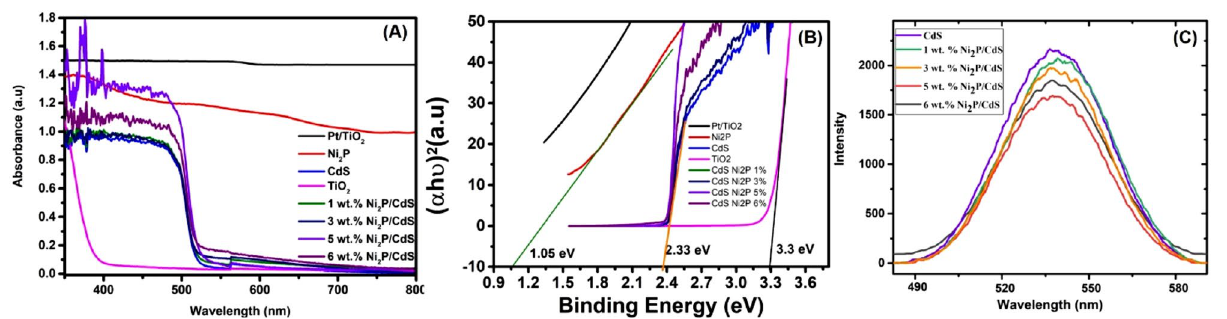
Figure 4. UV–Vis diffuse reflectance spectrum ( A ), Tauc plots ( B ) and photoluminescence spectrum of ( C ) of synthesized catalysts CdS, 1 wt% Ni 2 P/CdS, 3 wt% Ni 2 P/CdS, 3 wt% Ni 2 P/CdS, 5 wt% Ni 2 P/CdS and 6 wt% Ni 2